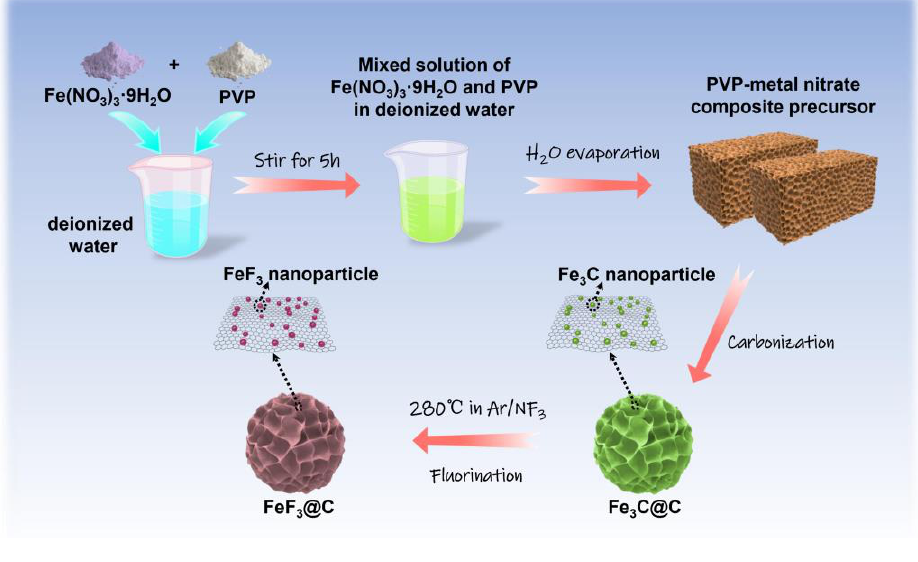
Figure 1. Schematic illustration of the synthetic process of the FeF 3 @C assemblies.